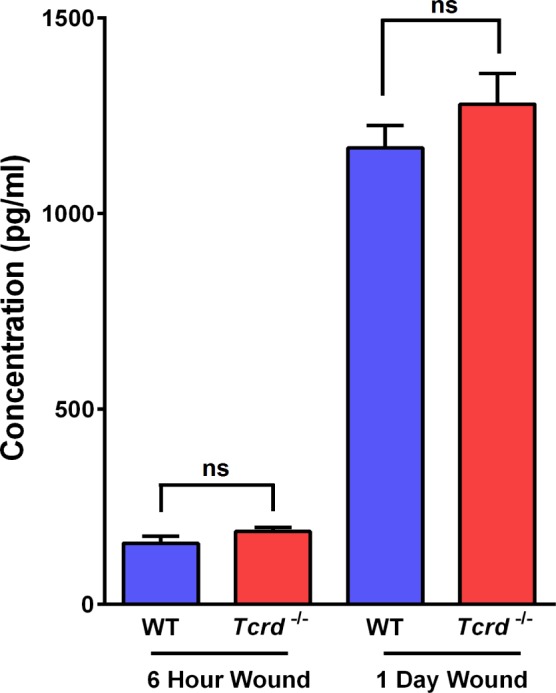
Quantification of secreted IL-1α from excisional wounds.Wounded 5-mm punch biopsies from WT and γδT-cell KO mice were used to condition media. ELISA for IL1α was performed on the conditioned media. Analysis was performed on 6 hr and 24 hr post-wounding samples. Differences between the secreted IL1α levels were not statistically significant (ns).